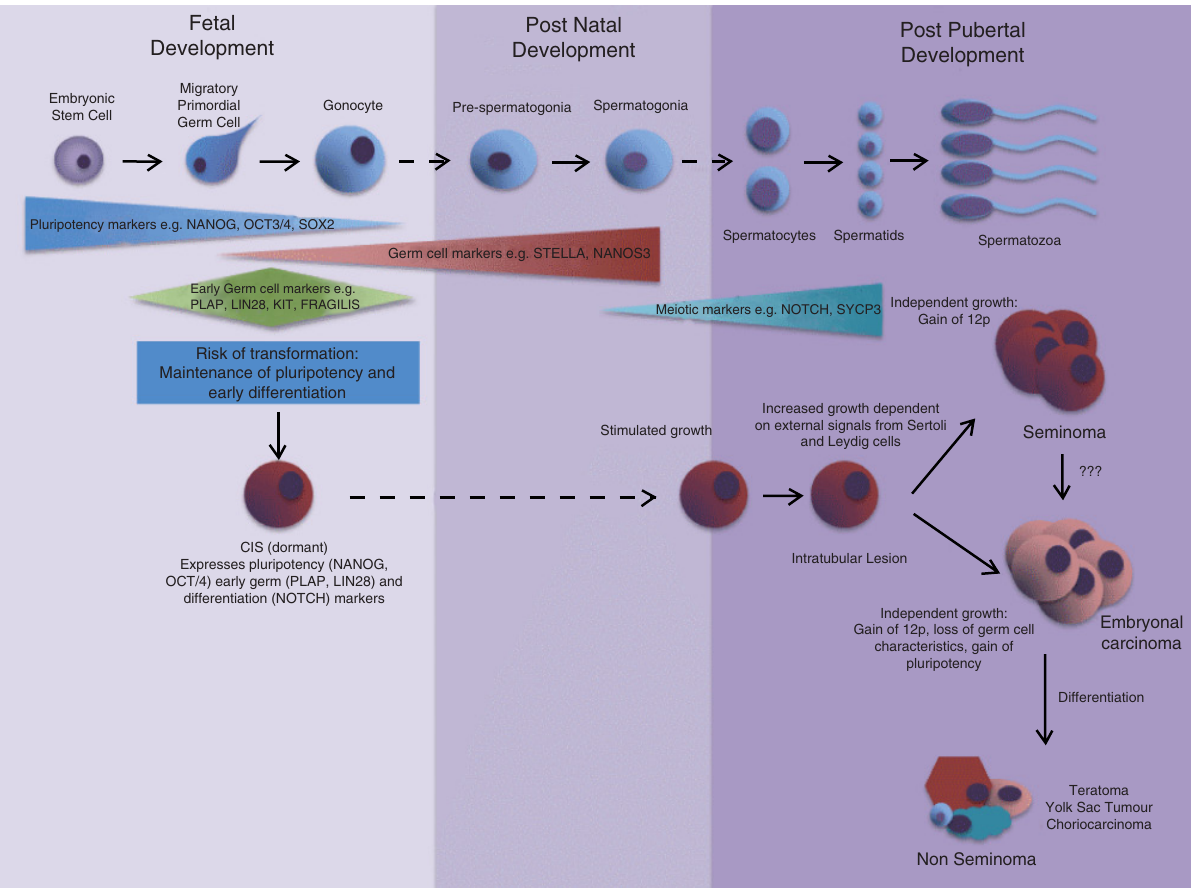
Figure 1. Proposed mechanism of type II testicular germ cell tumour (TGCT) differentiation. This is an update and adaption of the classic model of type II TGCT development first proposed by Rajpert-De Meyts 93 . Current understanding indicates maintained pluripotency combined with incomplete premature differentiation of gonocytes causes the specification of Carcinoma in situ (CIS) cells. Signals caused by puberty cause these cells to proliferate and once additional mutations accumulate CIS cells differentiate into overt type II TGCTs. Phosphatase)-positive PGCs reside in the posterior of the primitive streak and become motile shortly after this time 35,36